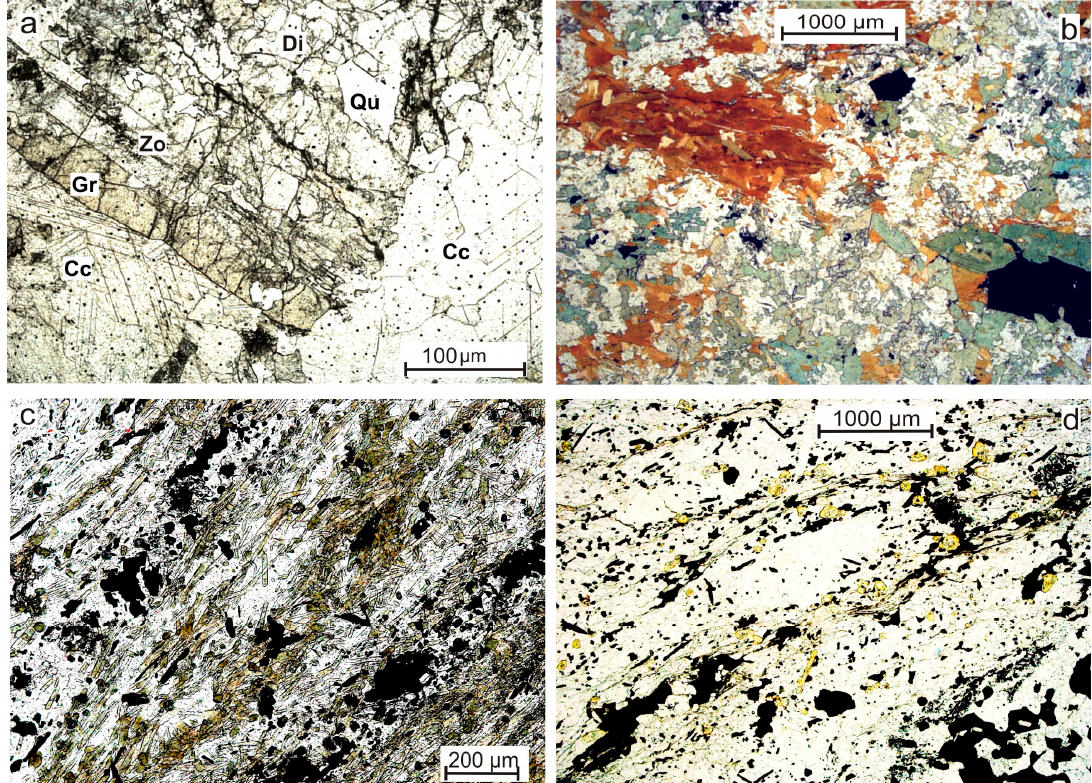
Figure 4. Altered rocks from the Oleninskoe deposit. Thin sections photos, transparent light, one polarizer: ( a ) diopside–zoisite–calcite–garnet metasomatite; ( b ) biotitizated hornblendite; and ( c ) and ( d) quartz–tourmaline metasomatic rock: ( c ) after granite porphyry, with arsenopyrite dissemination and ( d ) after hornblende amphibolite, with pyrrhotite–arsenopyrite mineralization.